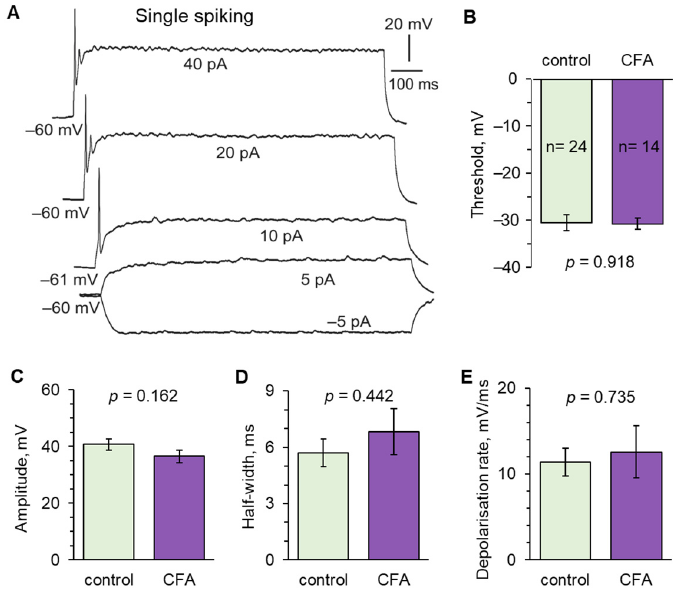
Figure 4. Peripheral inflammation does not affect firing by single spiking lamina I − II DH neurons. ( A ) An example of current-clamp recordings from a DH neuron displaying a single spiking pattern of discharge in response to a stepwise increase in depolarising currents of the indicated intensity. ( B ) Statistical summary of the AP threshold in single spiking DH neurons in the control and 1 d post-CFA groups. ( C ) Summary of the spike amplitude in the control and peripheral inflammation. ( D , E ) Statistical summary of the kinetics of APs analysed for the half-width ( D ) and the depolarisation rate ( E ) in the control and inflamed groups. All data are means with SEM; the number of recorded cells is indicated. Unpaired two-tailed t -test is indicated).